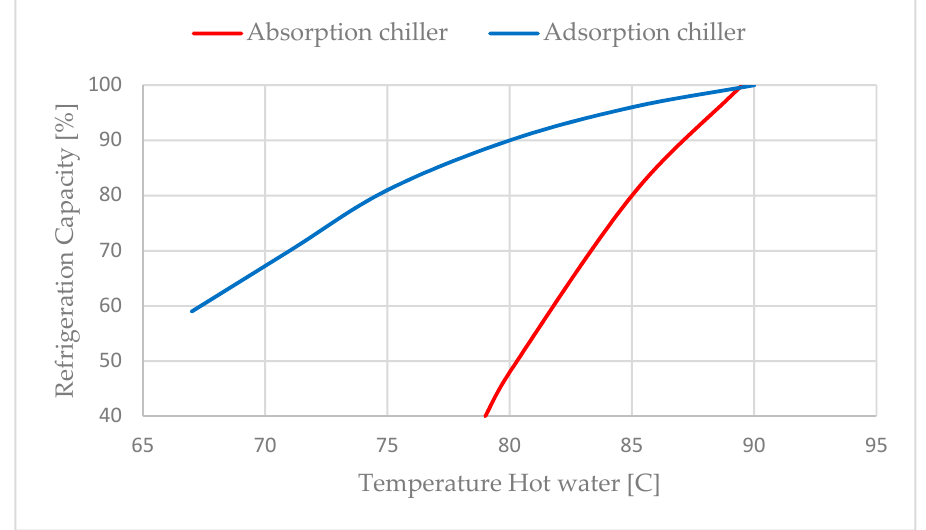
Figure 4. Cooling efficiency of adsorption and absorption chillers depending on the feed temperature Figure 4. Cooling e ffi ciency of adsorption and absorption chillers depending on the feed [21]. temperature